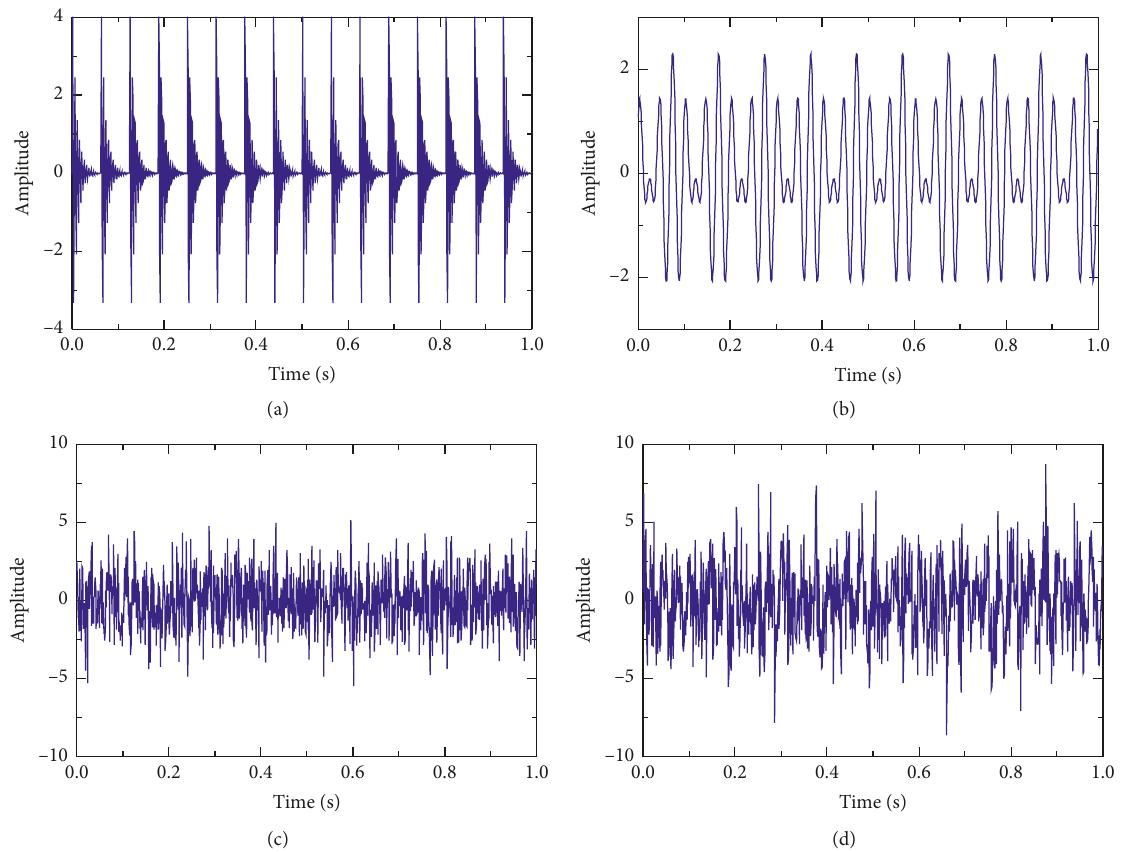
Figure 2: (a) Impulsive signal y